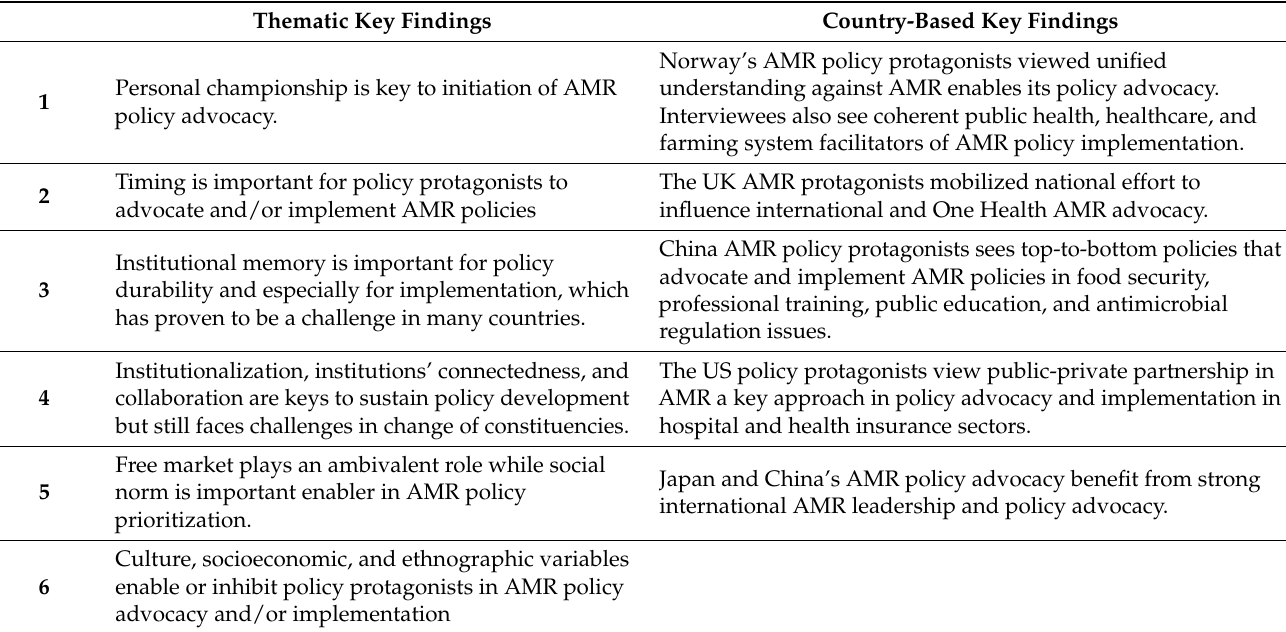
Table 3. Grounded Theory thematic and country-based key